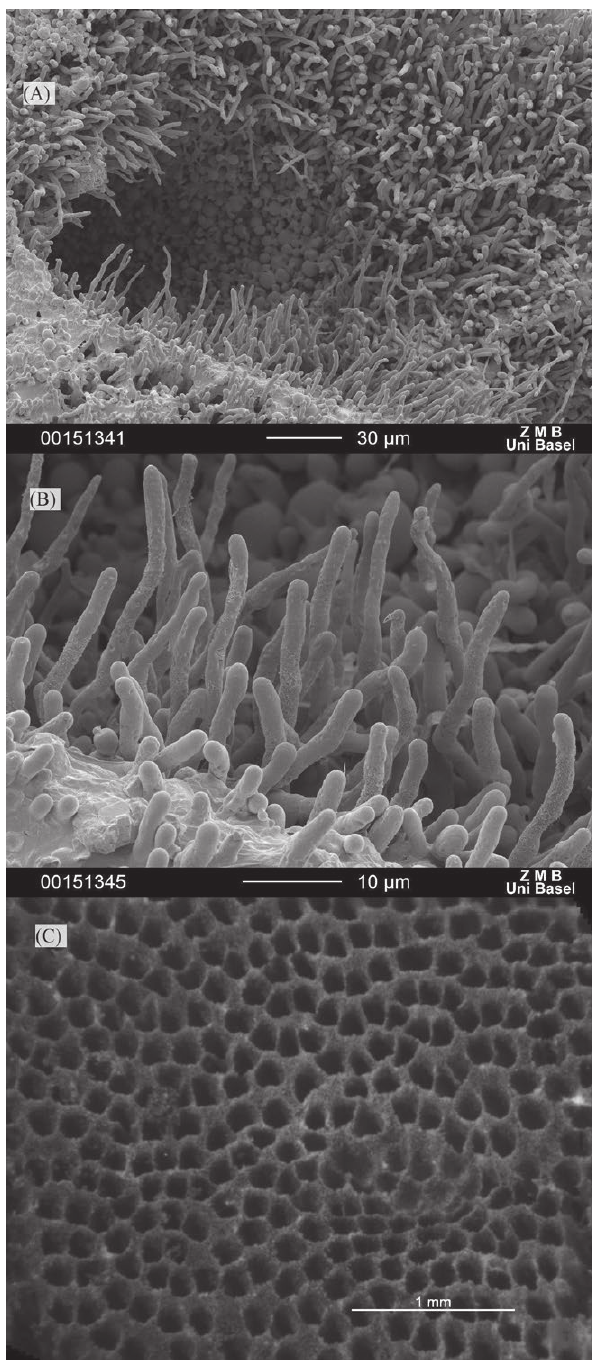
Figure 3. ( A ), Cryo-Scanning-Electron-Microscopy (Cryo-SEM) micrograph (×500 magnification) of an Fmed tube mouth show- ing outgrowth of vegetative hyphae. ( B ), Cryo-SEM micrograph (×2,000) of hyphae in a cross section of a grapevine trunk natu- rally affected by white rot. ( C ), Stereo micrograph of the surface of an Fmed fruiting body (×50) The pores are 5-8/mm. The diseased grapevine specimen was collected in a vineyard in Pfaffenweiler, south-west